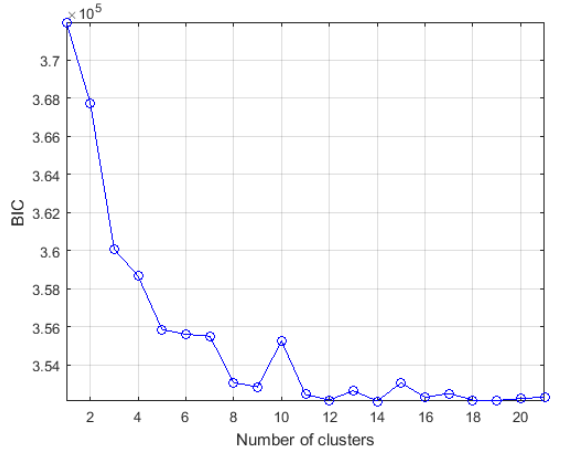
Figure 5. Fixation assignment to 6 clusters for the P2 image .